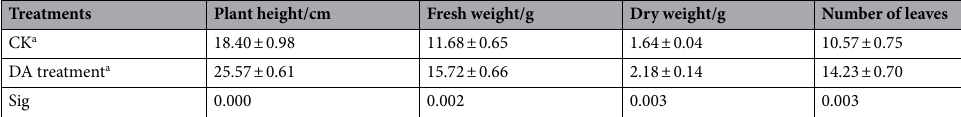
Table 2. Effects of HT-COS treatment on B. napus growth. a Data are mean ± standard error. The results of the independent samples t-test showed that the difference between samples was significant when Sig. < 0.05.